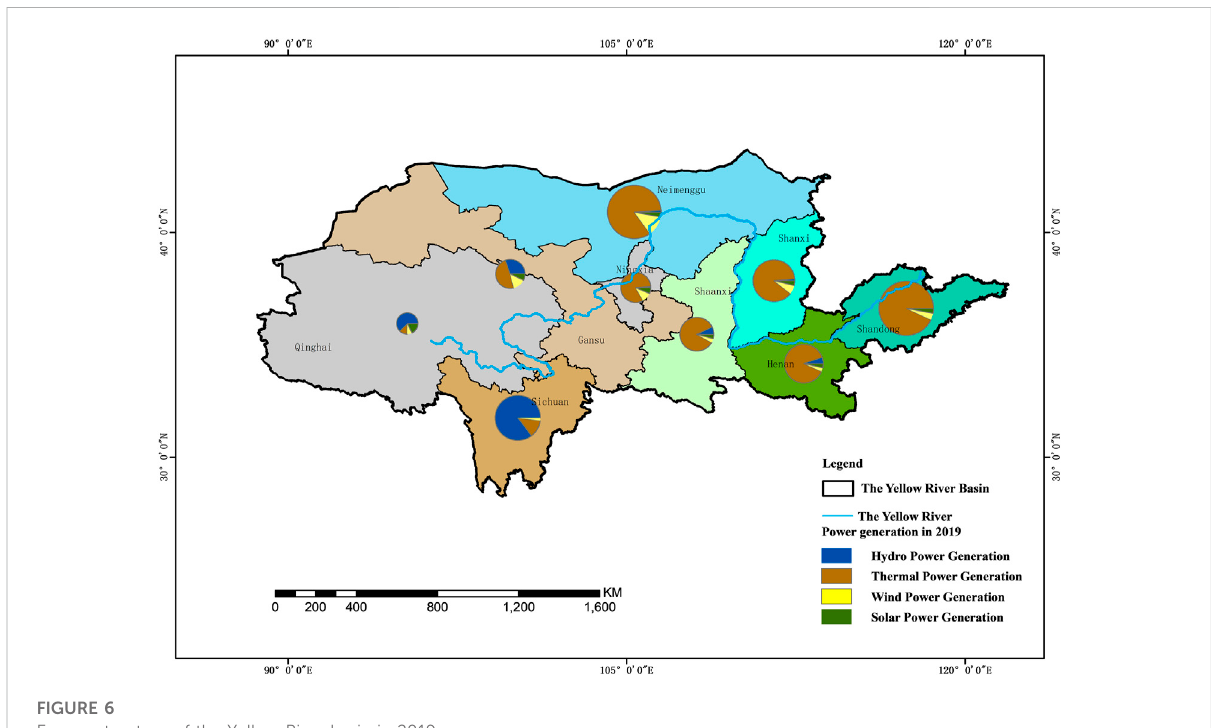
FIGURE 6 Energy structure of the Yellow River basin in